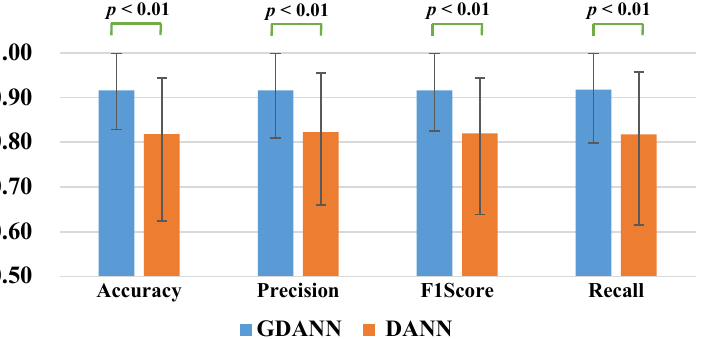
Figure 9. Paired Difference Analysis between four indicators of DANN and GDANN by Wilcoxon Signed Ranks.